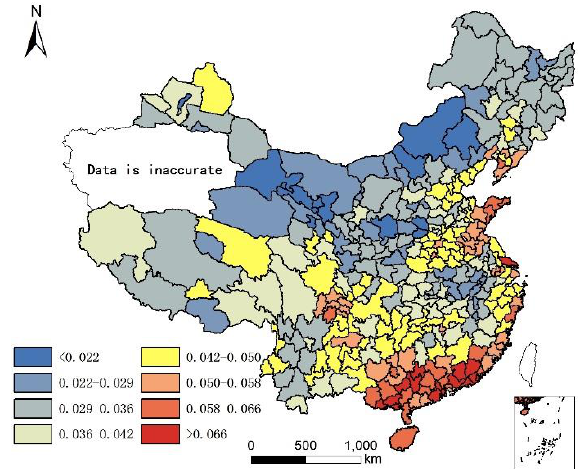
Figure 1. Longevity rate (85+/65+) in China in 2000.